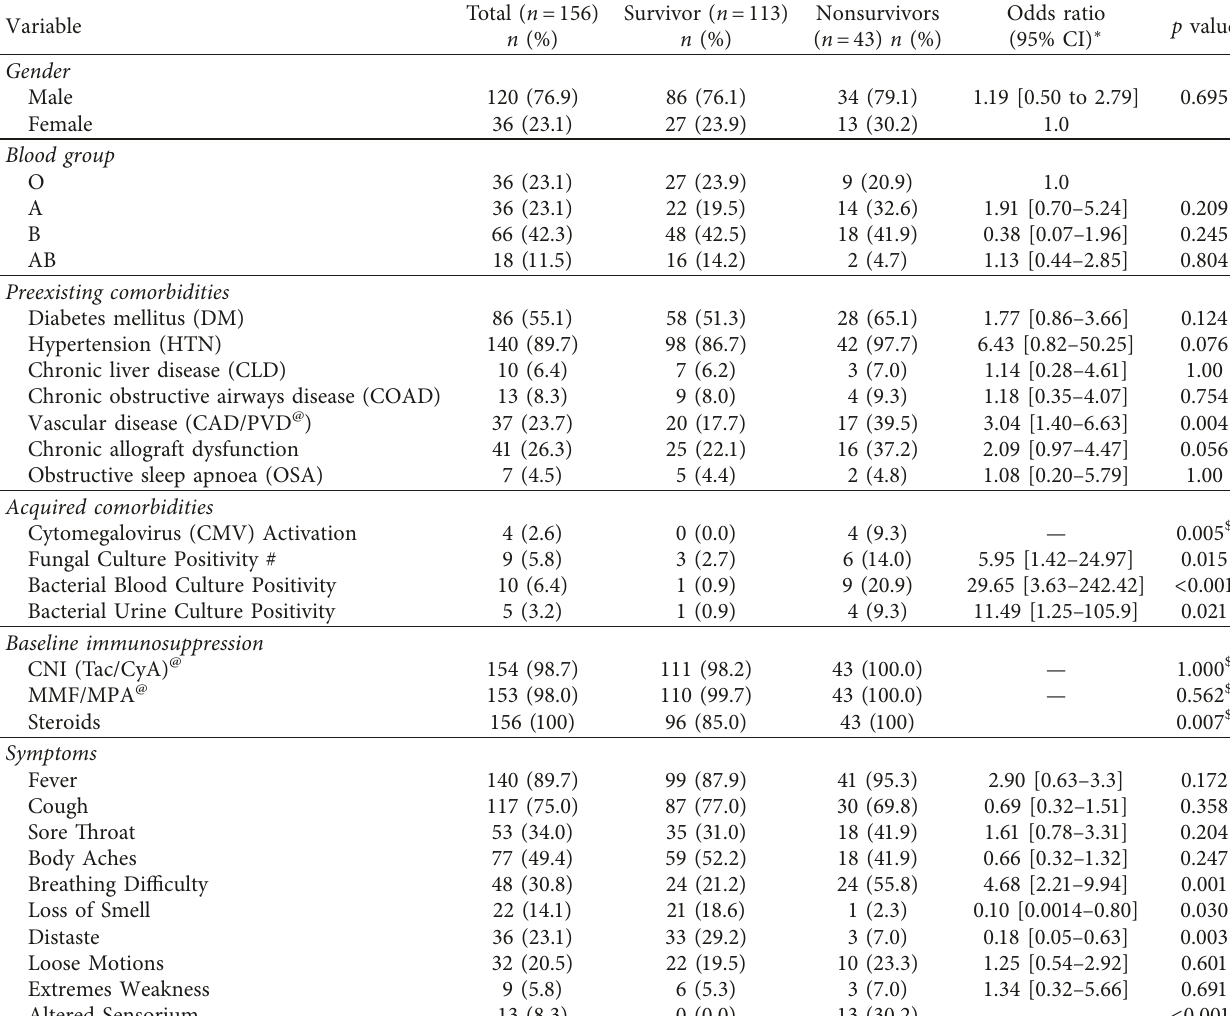
Table 4: Comparison between survivors and